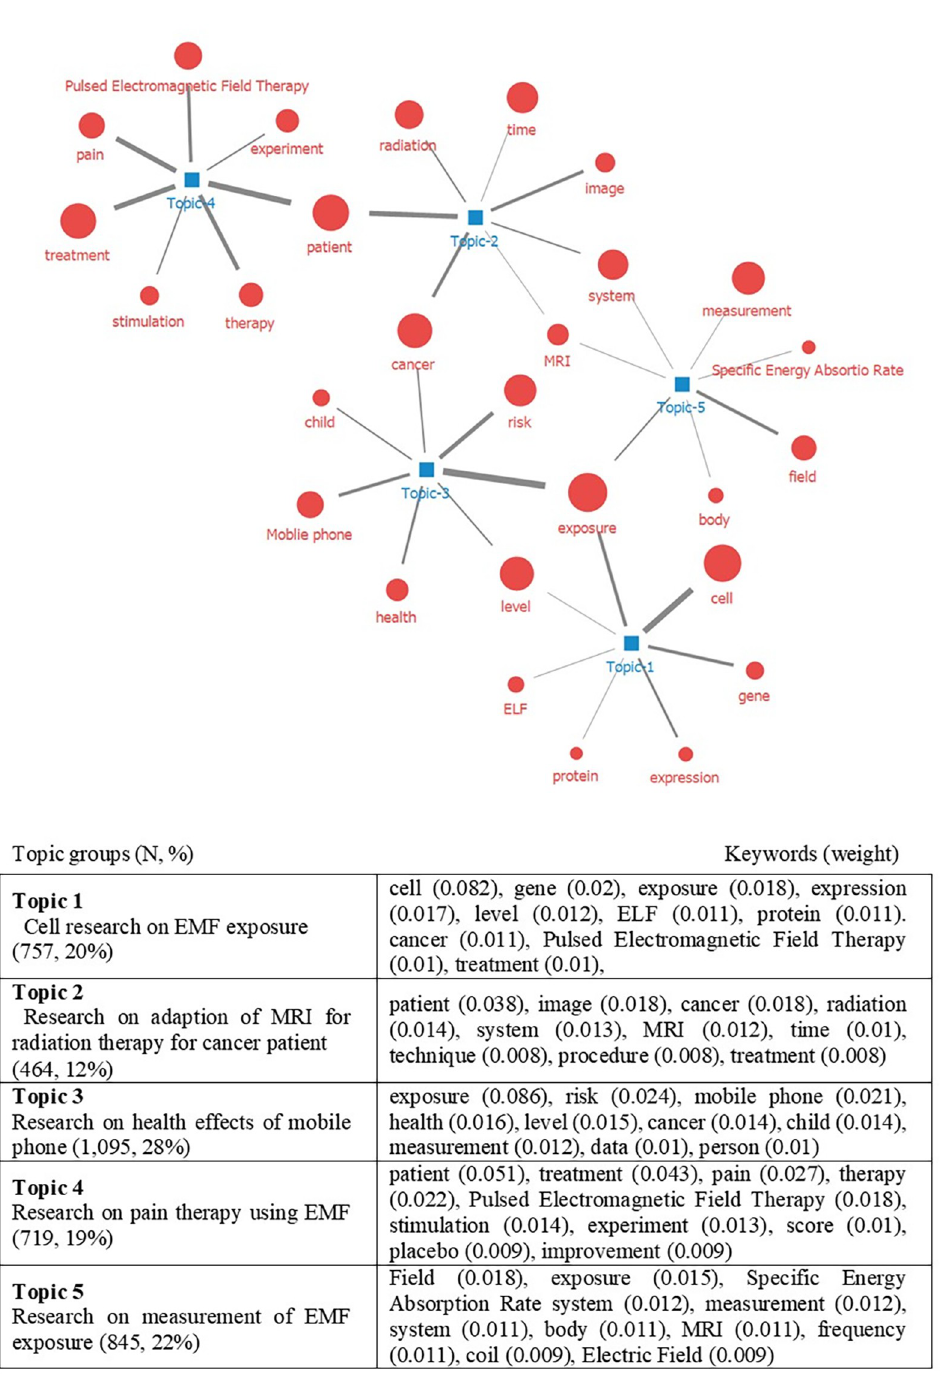
PLOS ONE | https://doi.org/10.1371/journal.pone.0273005 August 17,